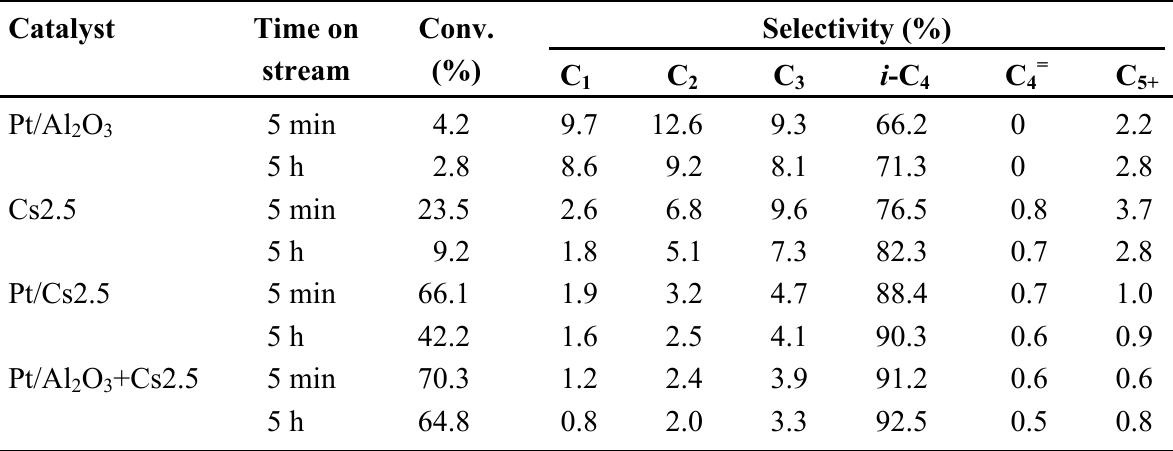
Table 1. Catalytic hydroisomerization of n -butane over various catalysts at 573 K. Catalyst Time on